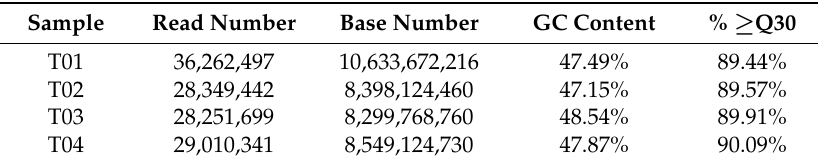
Table 2. Statistical data for sample sequencing.